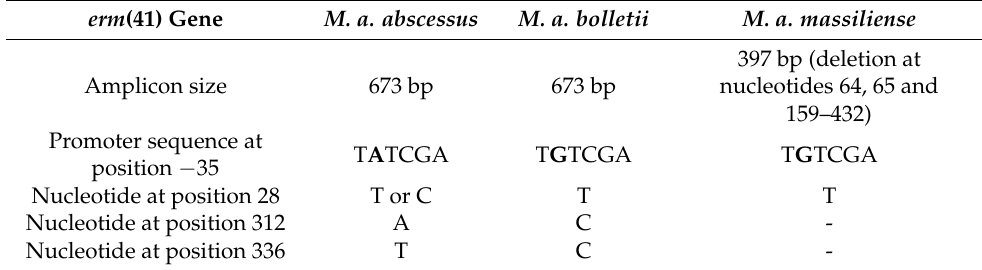
Table 2. Sequence differences identifying M. a. subspecies. erm (41)